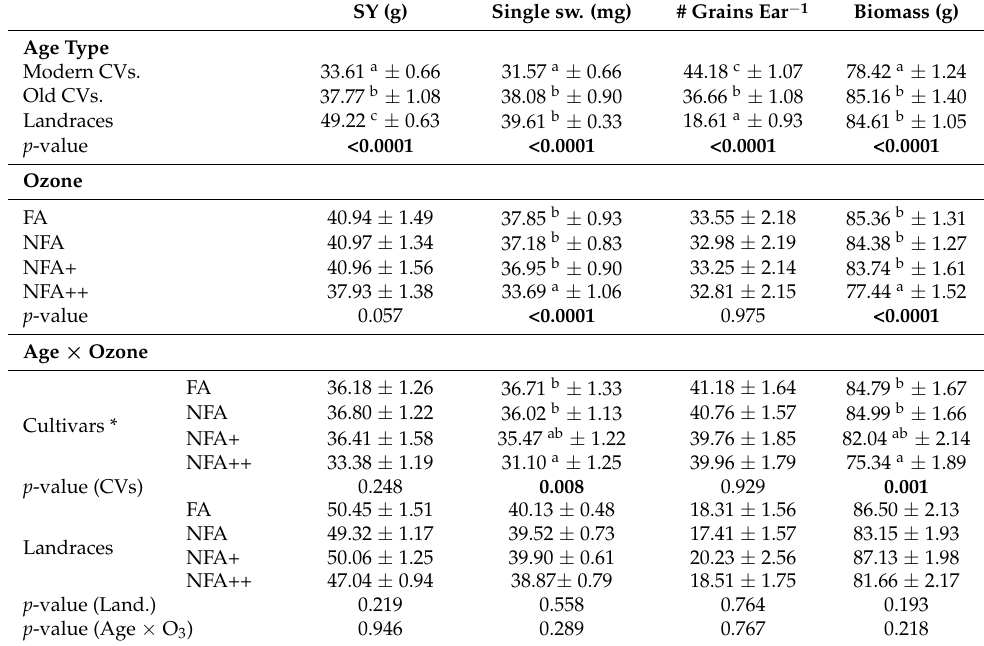
Table A1. Ozone and age type effects on yield parameters: SY, straw yield (g pot − 1 ); Single sw., single seed weight (mg); # grains ear − 1 , number of grains per ear per pot; Biomass, added value of the straw yield and the ears with grains (g pot − 1 ). FA= charcoal filtered air, NFA = non filtered air, NFA+ = non filtered air supplemented with 20 nL L − 1 of O 3 , NFA++ = non filtered air supplemented with 40 nl L − 1 of O 3 ; Mean values ± SE. Different letters indicate statistically significant differences ( p < 0.05). SY (g) Single sw. (mg) # Grains Ear −